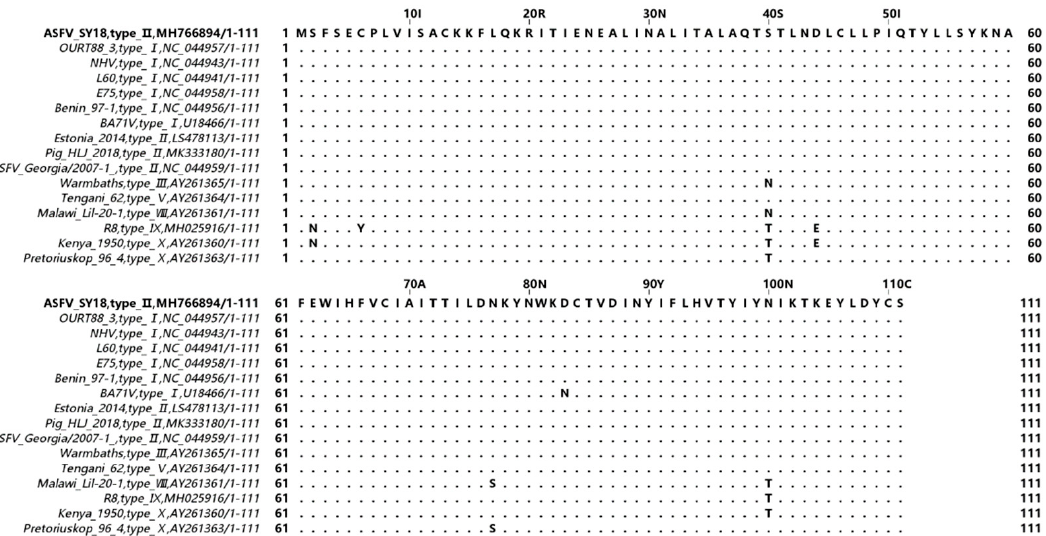
Figure 2. Comparison of E111R amino acid sequences in 16 different ASFV isolates. The E111R of ASFV SY18 was used as the reference sequence in the comparison, where single-letter abbreviations indicate amino acid sequences. Different letters indicate other amino acids; the same amino acid is shown as “.”. The amino acid homology of pE111R between isolates is 95.5% to 100%.